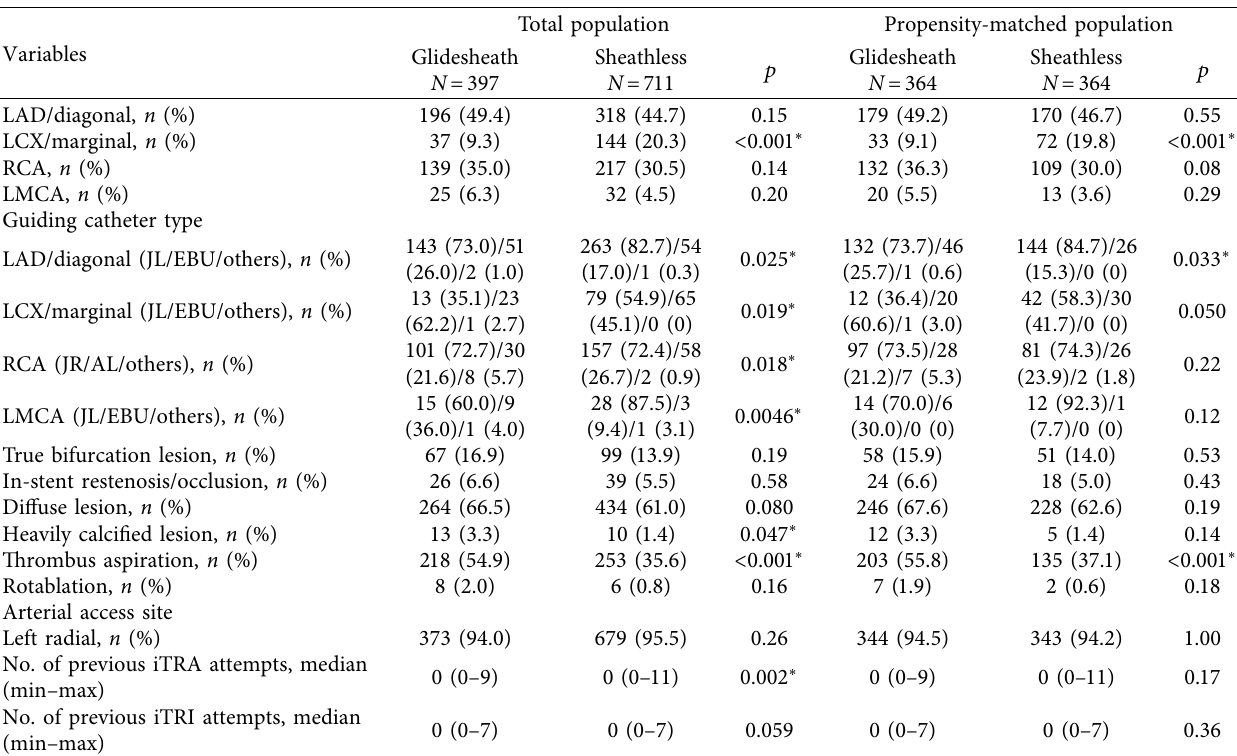
Table 2: Procedural characteristics of the study population.